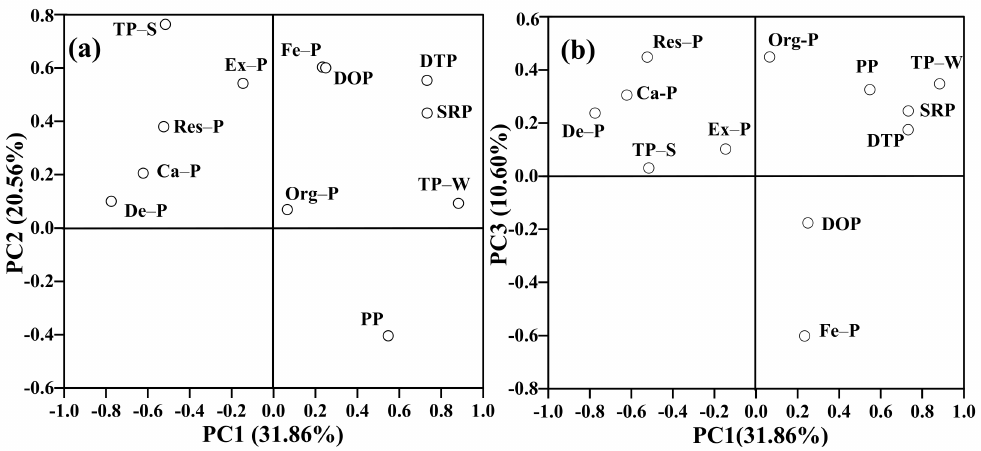
Figure 7. PC1 versus PC2 ( a ) and PC1 versus PC3 ( b ) of phosphorus fractions in water and sediment in the Tuojiang